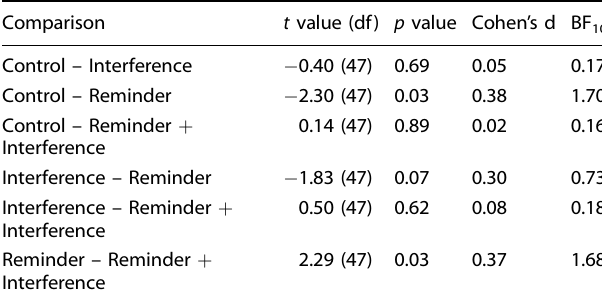
Table 6. Post-hoc paired samples t-tests comparing conditions on accuracy scores in Experiment 3 (with Cohen ’ s d effect size and Bayes factors included).